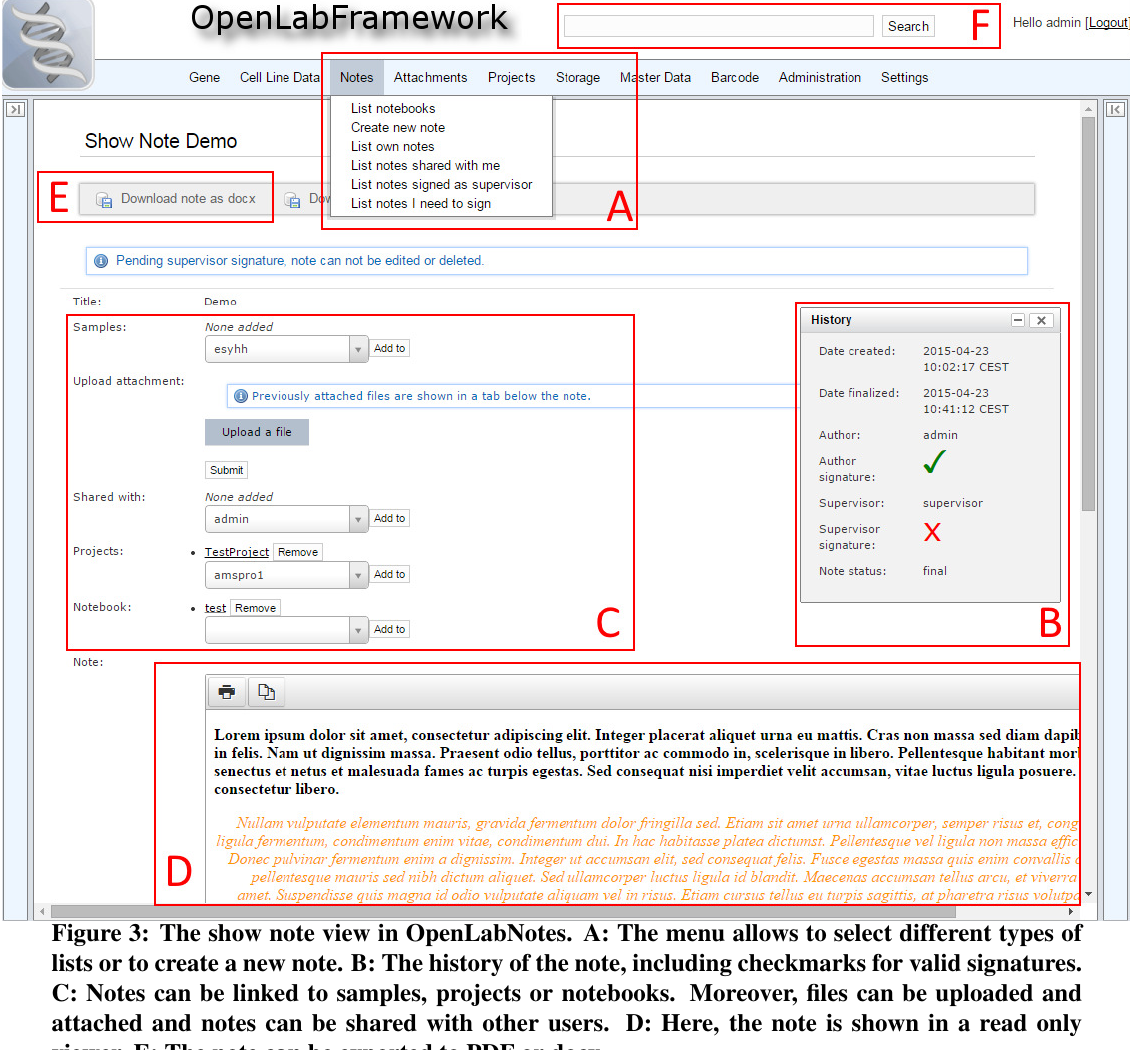
Figure 3: The show note view in OpenLabNotes. A: The menu allows to select different types